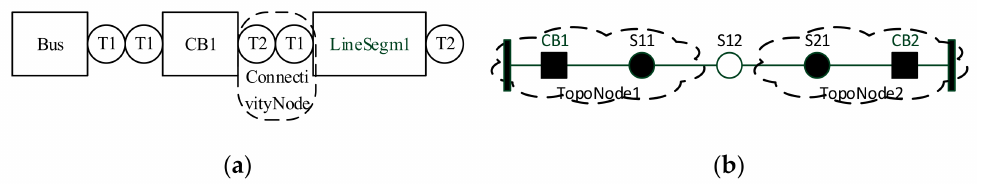
Figure 4. Feeder topology model: ( a ) connectivity model; ( b ) topology